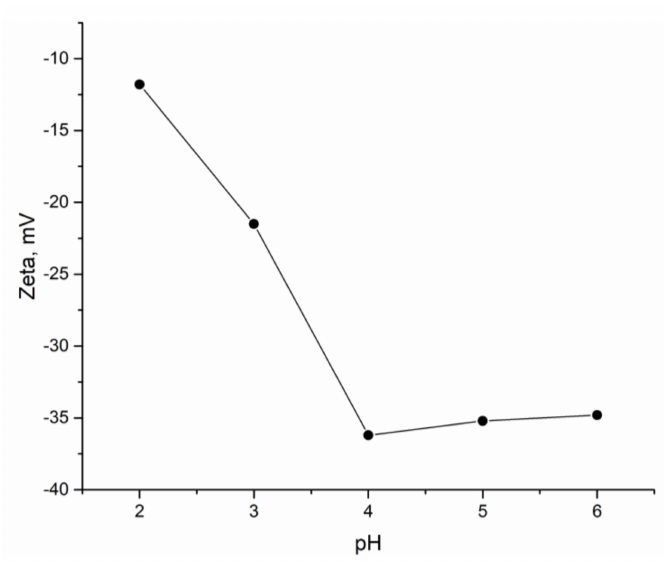
Figure 2. Zeta potential of hybrid biosorbent as a function of